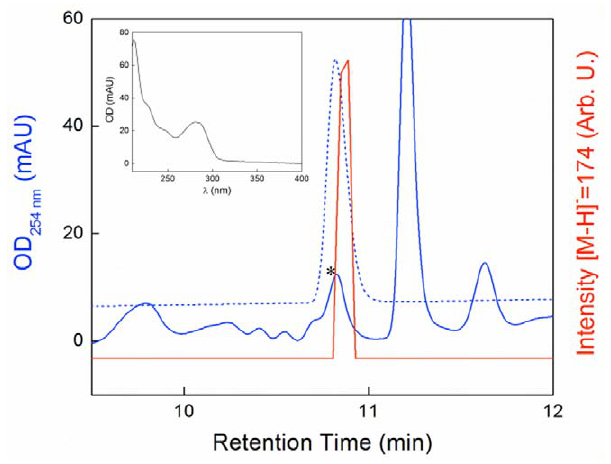
Figure 2. HPLC-MS analysis of Ruegeria strain R11 cultures extracted with acidified EtOAc. The extract was separated on a C18 column, and the elution profile, monitored at 254 nm, is shown (blue trace). At 10.8 min, a peak (black star) eluted with an absorption spectrum (inset) similar to that of IAA. The elution profile of authentic IAA (dotted blue trace), and an ion-extracted trace with the negative ion mass of 174, indicative of IAA, is also shown (red trace).